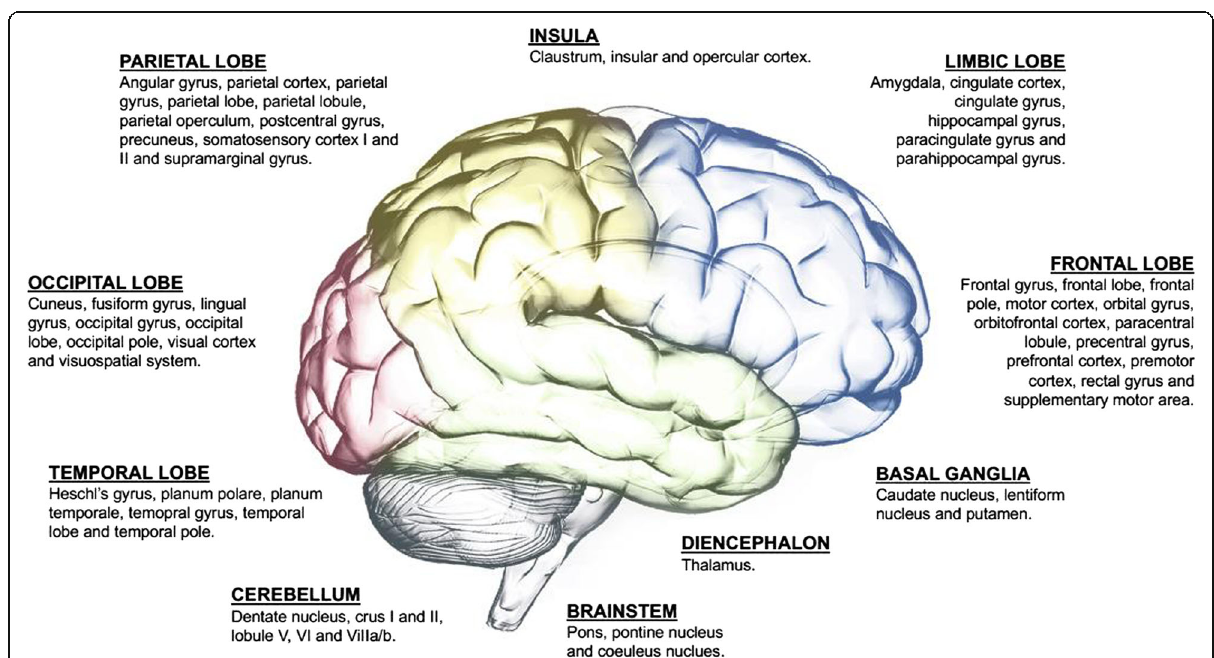
Fig. 2 Overview of areas which have affected functional connectivity to 20 different networks reported in a total of 25 studies of interictal migraine patients compared with healthy